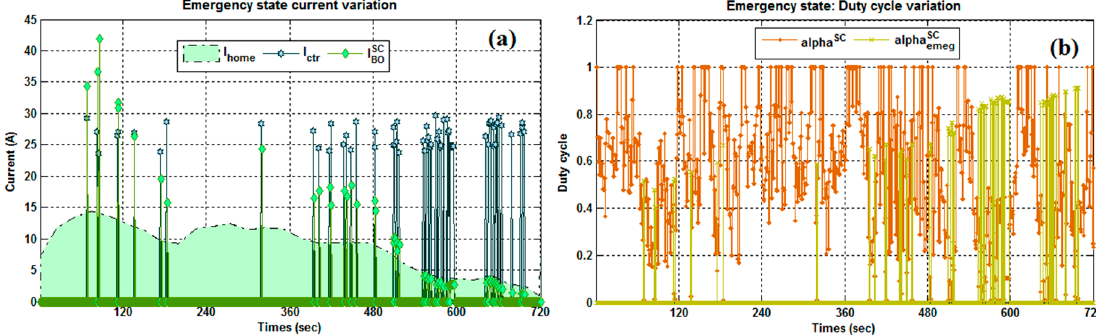
Figure 12. Emergency state: ( a ) SCap current variation and ( b ) duty cycle variation.